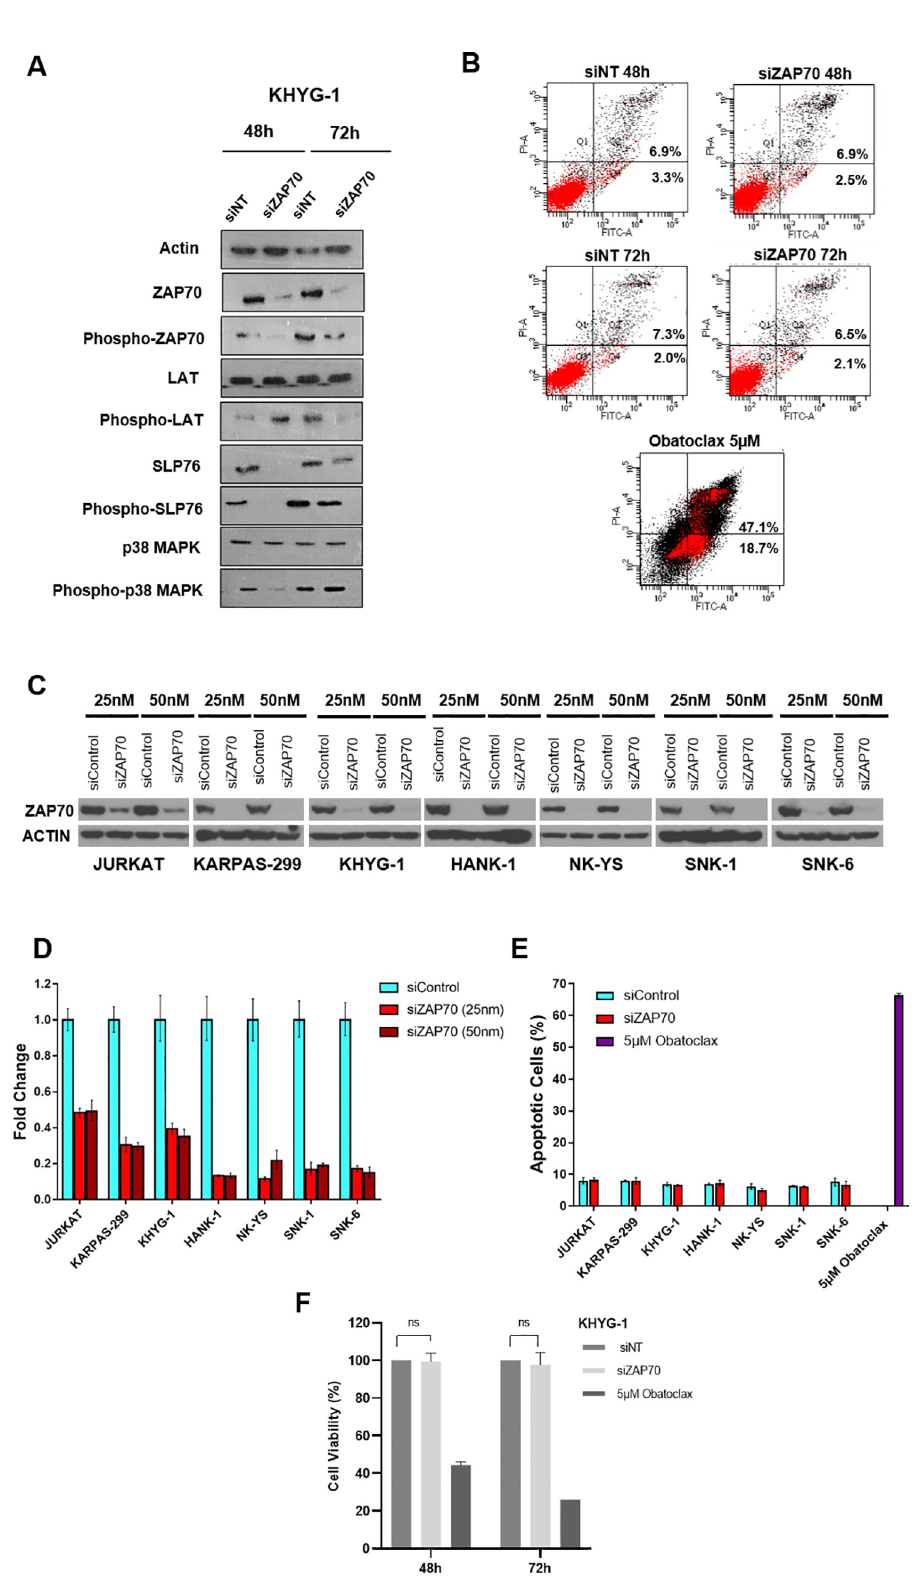
Fig 2. Knockdown of ZAP70 does not affect survival of T/NK Lymphoma cell lines. (A) KHYG cell line was treated with si Non Targeting Control (NT) or siZAP70 and immunoblot analysis of the protein expression of